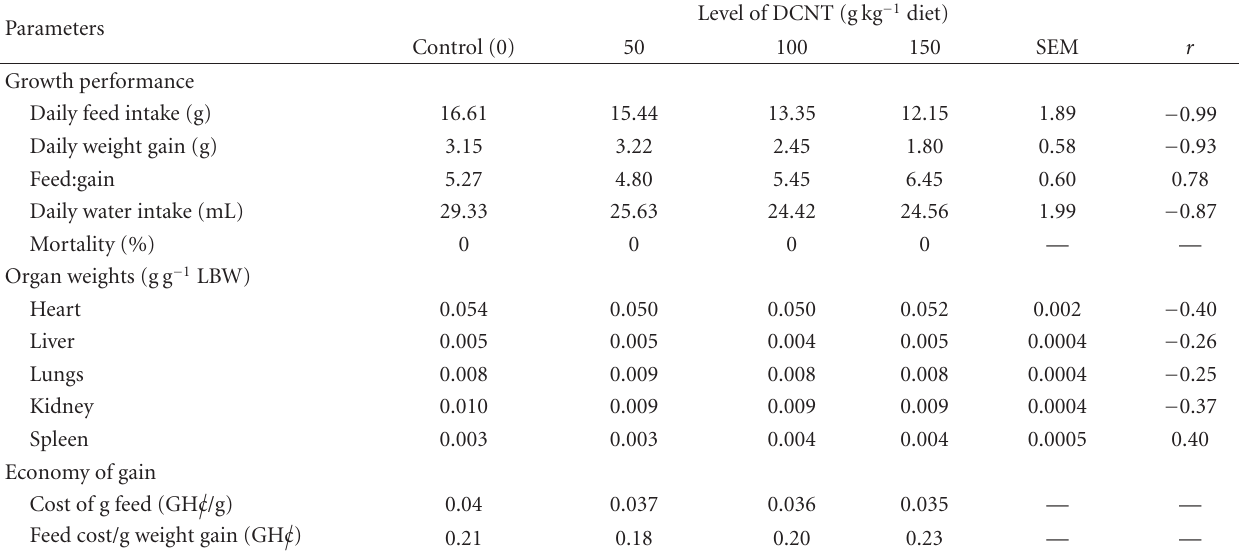
Table 3: E ff ect of varying amounts of DCNT on growth performance, organ weights, and economy of gain of laboratory rats. Parameters Growth